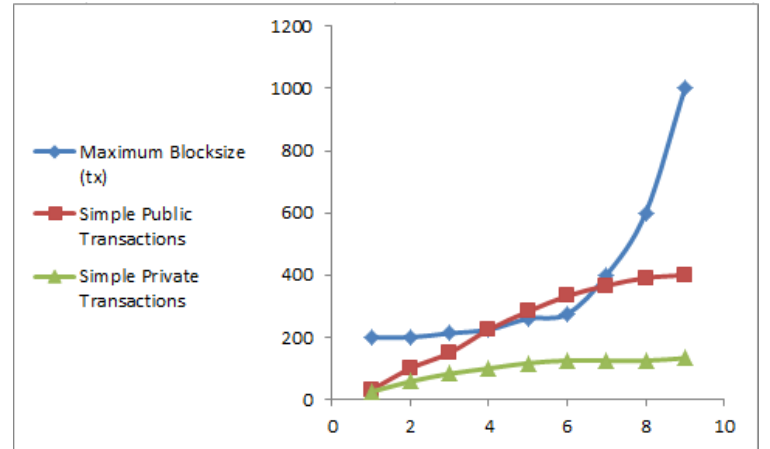
Figure 24. Maximum throughput vs. block size.